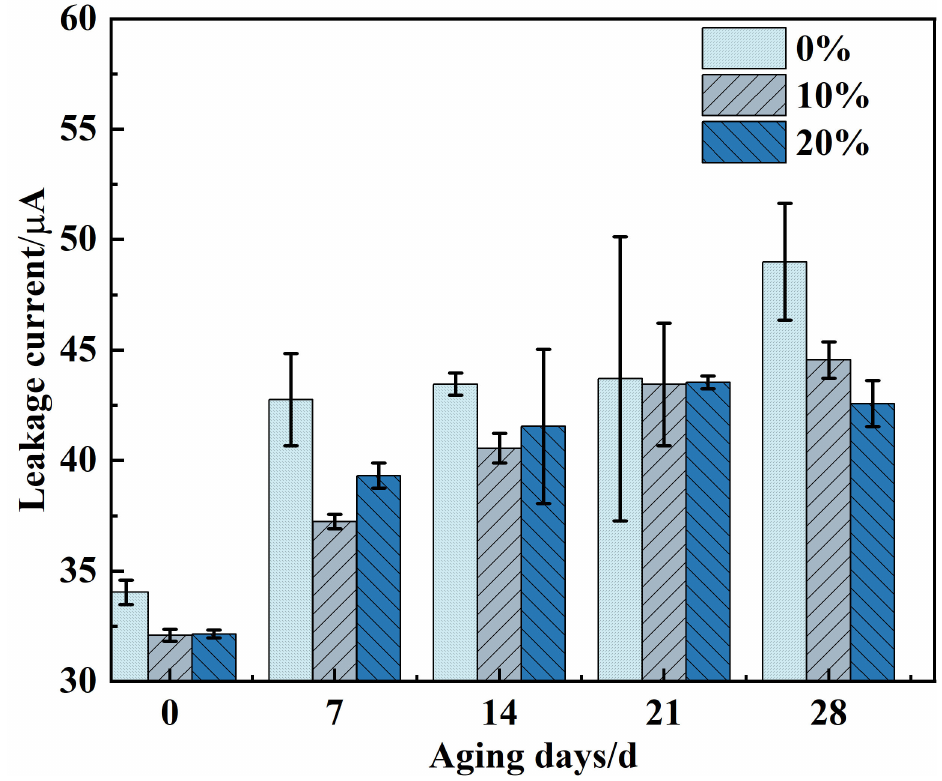
Figure 3. Leakage current of cycloaliphatic blend resins with different proportions during salt